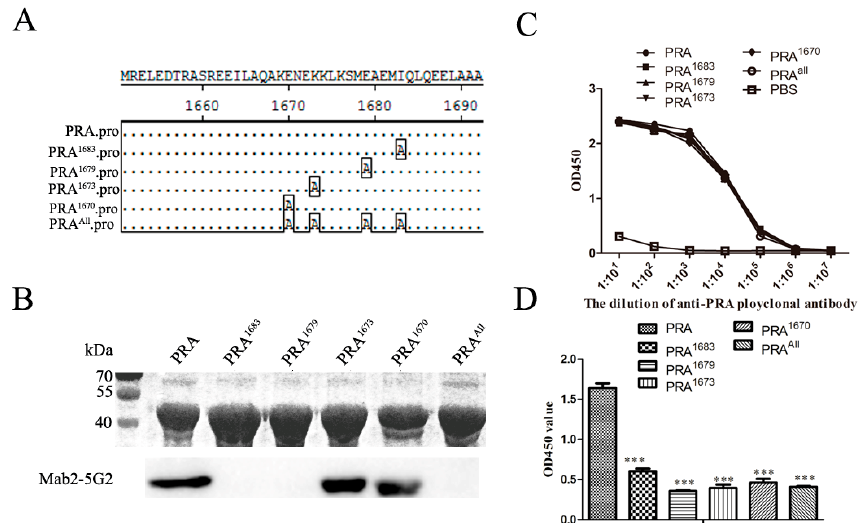
Figure 5. Mutagenesis of predicted Mab-5G2 docking sites on MYH9 affects binding of PRA to Mab2-5G2 and PRRSV virions. ( A ) Schematic illustration of point mutations introduced into the PRA region within the full-length MYH9 protein. ( B ) SDS-PAGE and Western blot analysis to evaluate recombinant protein purity and recognition by Mab2-5G2. ( C ) ELISA analysis to assay the binding PRA mutant proteins with the anti-PRA rabbit serum made by our lab. ( D ) ELISA analysis for quantification of binding between Mab2-5G2 and PRA mutant proteins using Mab2-5G2 as plate-coating protein and anti-PRA rabbit serum for detection of binding between Mab2-5G2 and PRA mutant proteins. ELISA data presented as the mean ± SD. Significant differences between the two groups are marked by “***” ( p < 0.001).